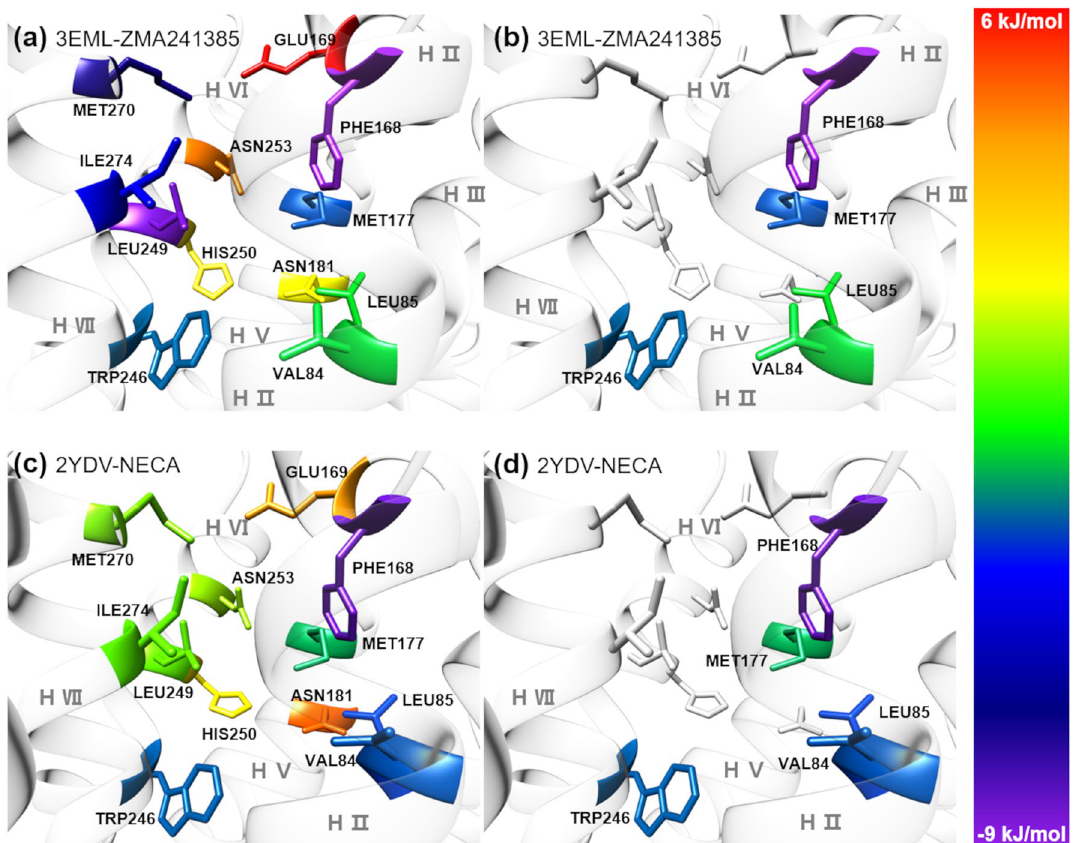
Figure 6. Decomposition of the MMPBSA-based total ligand binding energies ( E bind total ) at the individual residue level ( E bind res ). 12 Common residues within 5 Å of the ligands ( a ) ZMA241385 and ( c ) NECA in the binding pocket of the crystal structure of the A2A AR-ligand complex (PDB ids: 3EML and 2YDV, respectively). 5 structural hotspot residues which are common and contribute favorably to the binding energies of both the ligands ( b ) ZMA241385 and ( d ) NECA by < − 1 . 00 kJ/mol and are present within 5 Å of the ligands inside the binding pocket of A2A AR. The residues are colored based on their contribution, E bind res , reported in Supplementary Information, Table S3, to the E bind total (see colour